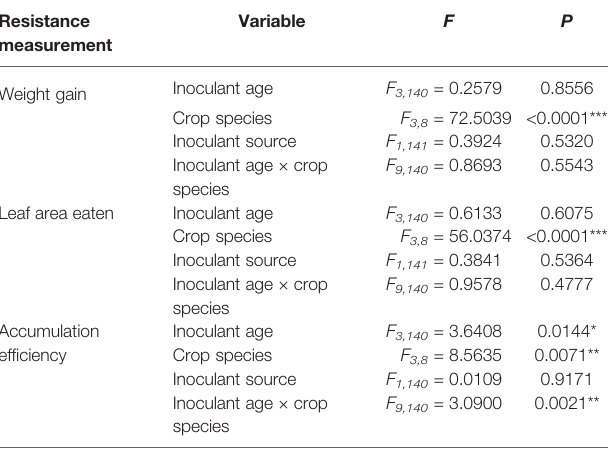
TABLE 3 | Results of ANOVAs assessing the overall effects of soil microbial inoculants on resistance to S. frugiperda in a no-choice test across crop species. Resistance measurement